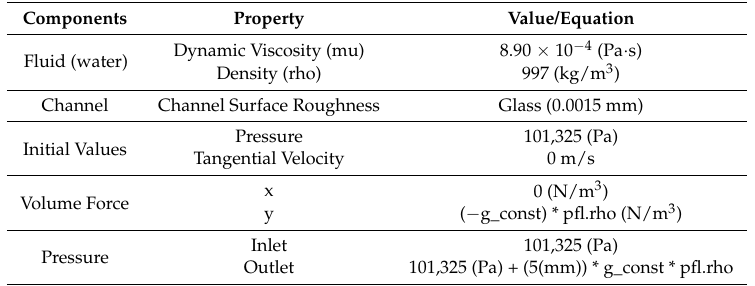
Table 1. Properties, constants, and boundary conditions used for the